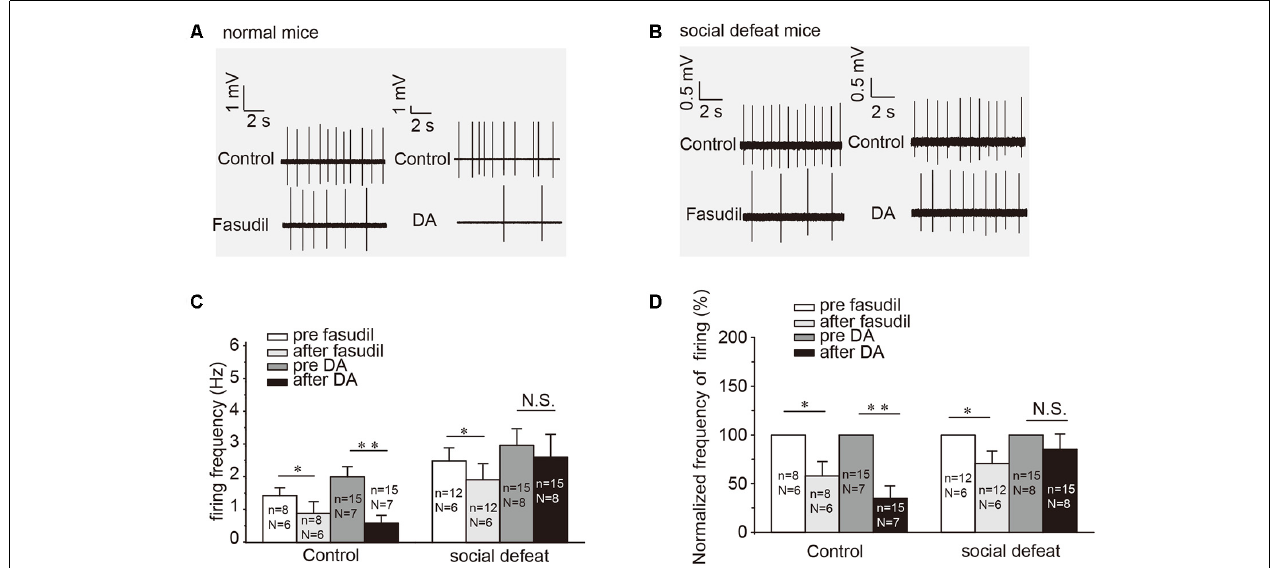
FIGURE 4 | DA-induced inhibition on the firing of NAc-projecting VTA DA neurons is reduced in the social defeat model of mice. (A,B) Example traces from cell-attached recordings of NAc-projecting VTA DA neurons are shown before and after administration of fasudil (a selective Kv7.4 opener; 10 µ M) and DA (20 µ M) in the control and the social defeat model mice. (C) Summarized the effect of fasudil and DA on the spontaneous firing frequency of NAc-projecting VTA DA neurons. ∗∗ p < 0.01, ∗ p < 0.05; N.S., not significant, paired t -test. N = number of animals; n = number of recordings. (D) Normalized firing frequency based on the data shown in C. Error bars represent SEM. ∗∗ p < 0.01, ∗ p < 0.05; N.S., not significant, one-sample Wilcoxon signed ranks test.